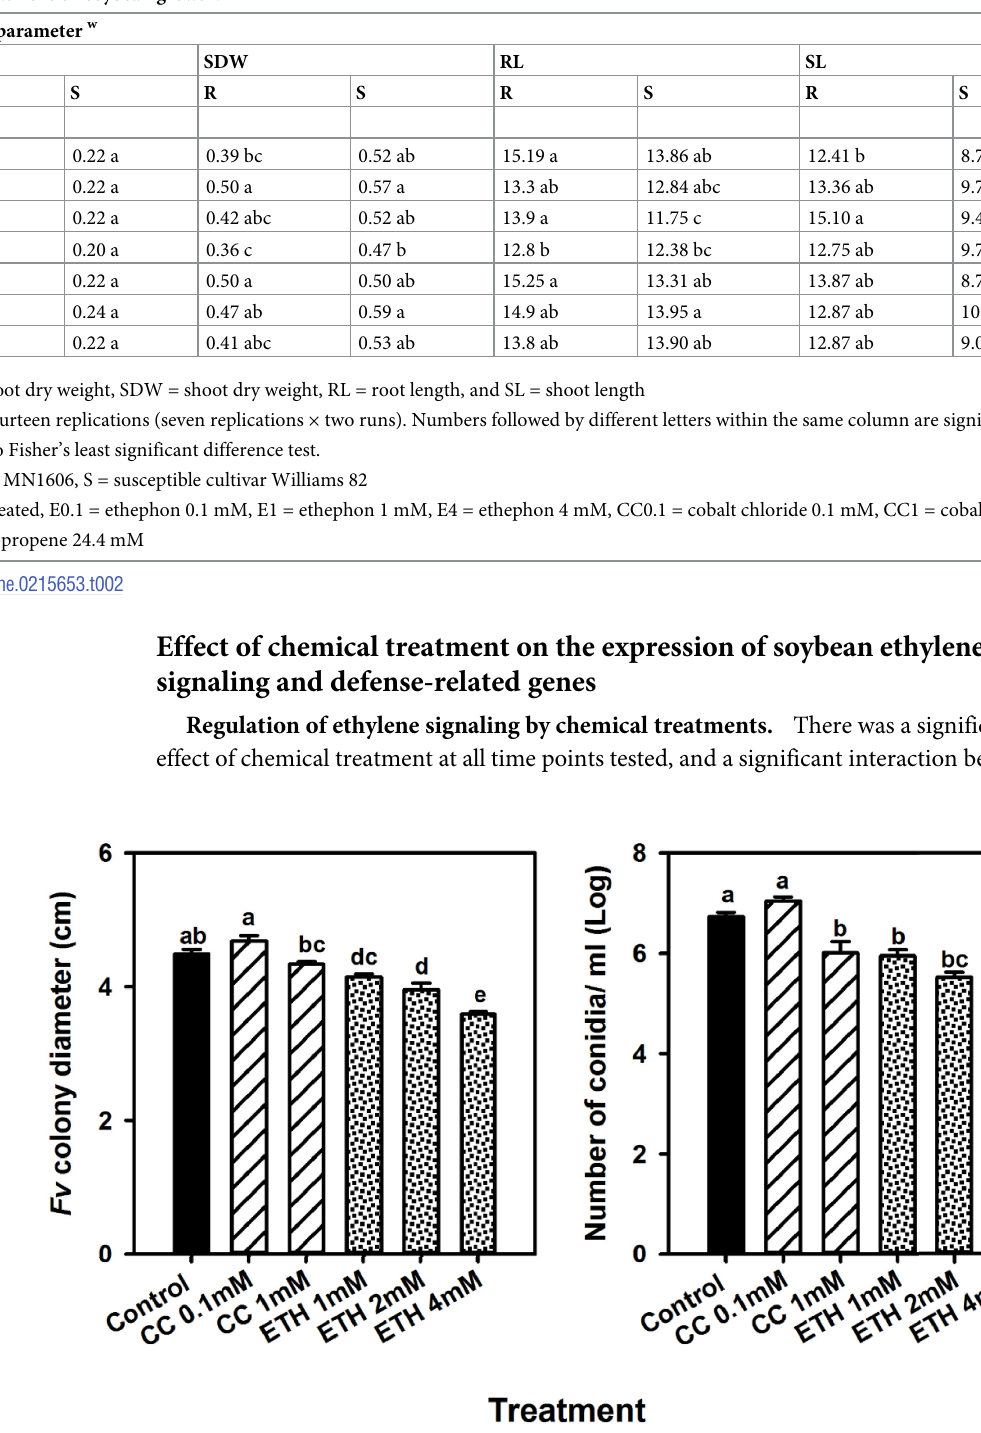
Table 2. Effect of chemical treatment on soybean growth.